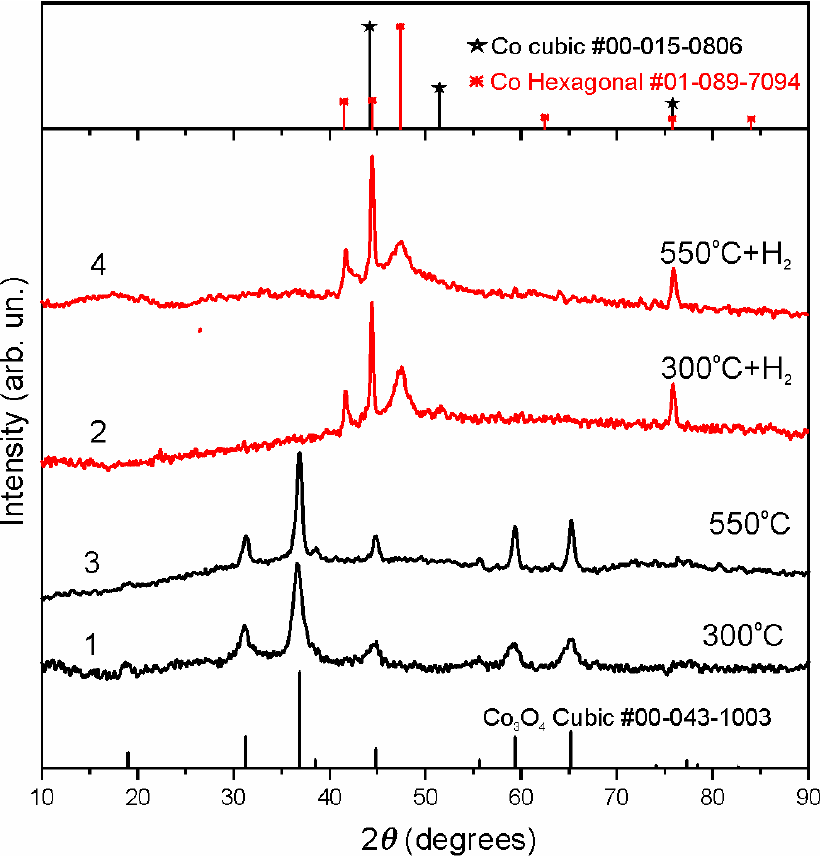
Figure 1. XRD patterns of the cobalt oxide (Co 3 O 4 ) samples synthesized at the temperature of 300 °C ( 1 ) and 550 °C ( 3 ) and annealed in hydrogen at 300 °C ( 2 , 4 ). The obtained cobalt oxide powder was then reduced by annealing in hydrogen atmosphere.